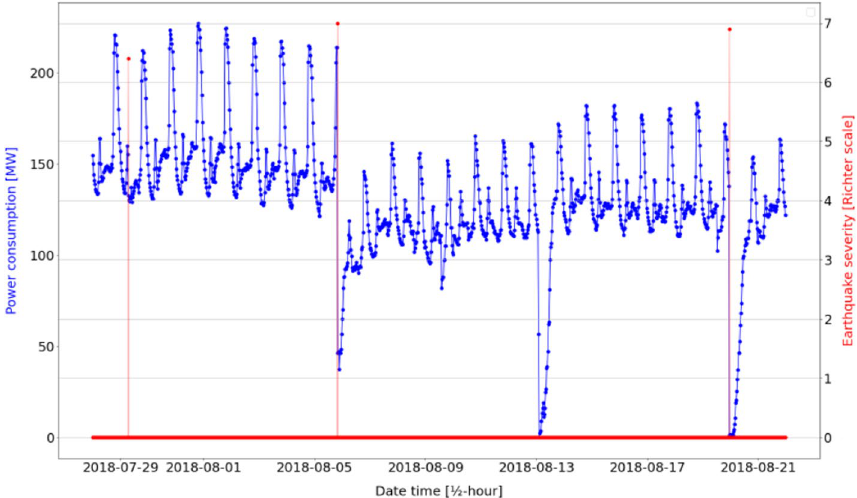
Fig. 27 The electricity consumption (left y-axis) and earthquake events (right y-axis) in Lombok Indonesia in